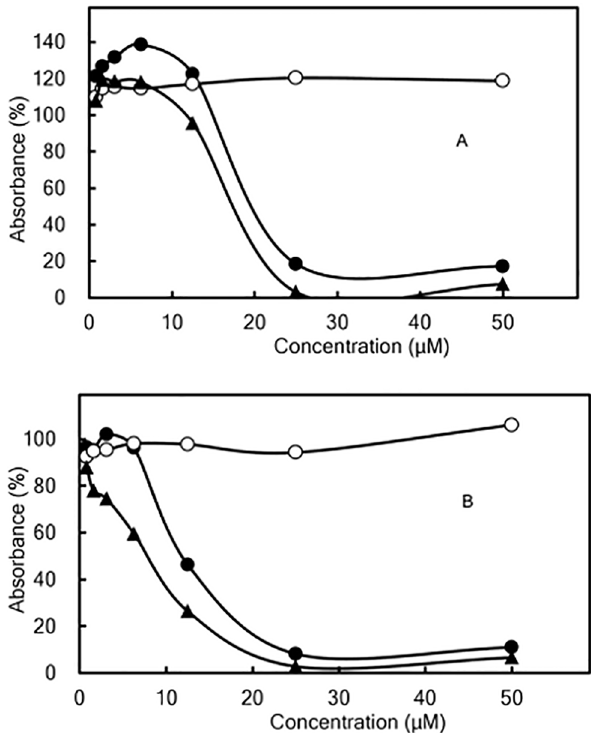
Fig 2. Dose-Response Curves of Curcumin/Liposome in Inhibition of Cell Proliferation. THP-1 (panel A) or RAW264.7 (panel B) cells were cultured for 3 days in the presence of curcumin/liposome ( ● ), curcumin ( ▲ ), and control liposomes ( (cid:1) ), respectively. After culturing, they were incubated with WST-8 for 3 h to assess viable cells in the culture. Resultant coloring reaction by WST-8 was measured with a plate-reader at the absorbance of 450 nm. In the vertical axis, the absorbance of only the medium was defined as 0%. Symbols in the Figure represent the percentage of absorbance with curucmin or liposomes to that without the test samples. Data represent mean values ± range (bars) in duplicate